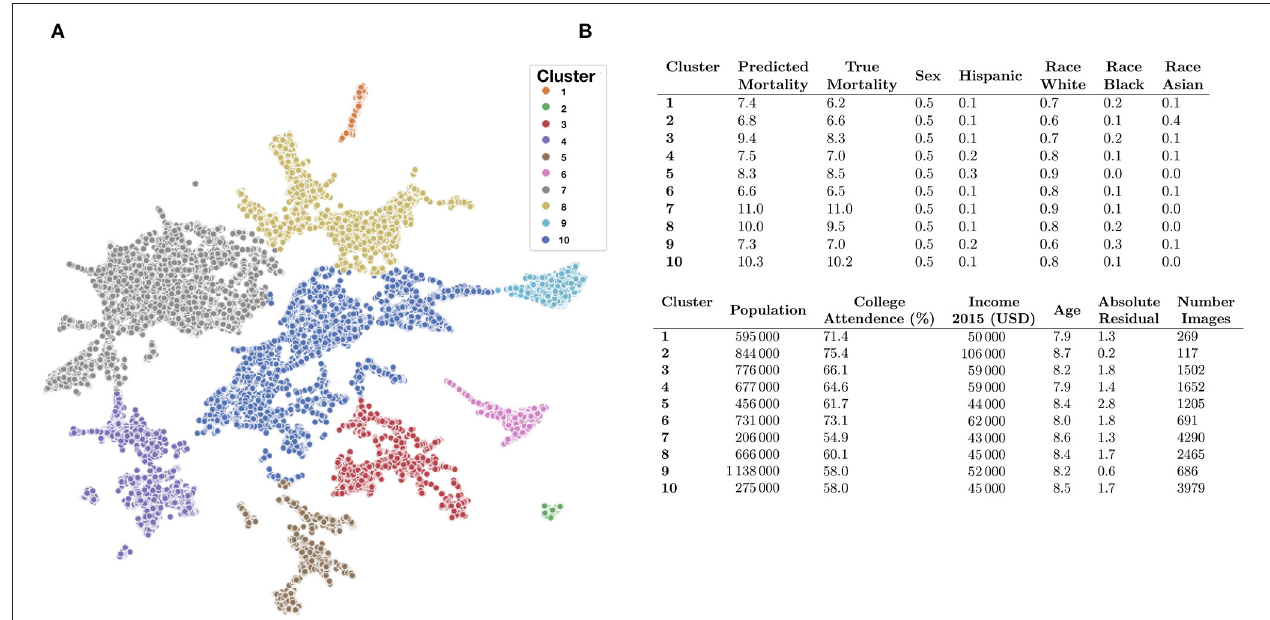
FIGURE 6 | Key covariate characteristics of found image clusters. (A) 2-D UMAP plots colored by cluster as estimated through Spectral Clustering; (B) averaged covariate statistics for each image cluster; average population and income estimates rounded to thousands place; statistics average county-level covariates, weighted by constituent images, covariates include: (1) average predicted mortality for the cluster, (2) average true mortality assigned to the cluster, (3) proportion female/male, (4) proportion Hispanic, (5) proportion white, black, or Asian, (6) average population, (7) proportion attend college, (8) average household income, (9) average age of population (in increments of 5-years per description in the Supplementary Materials ; e.g., 7.9*5 years = 39.5 years old), (10) Absolute Residual between true and predicted mortality, (11) number of images for cluster/size of